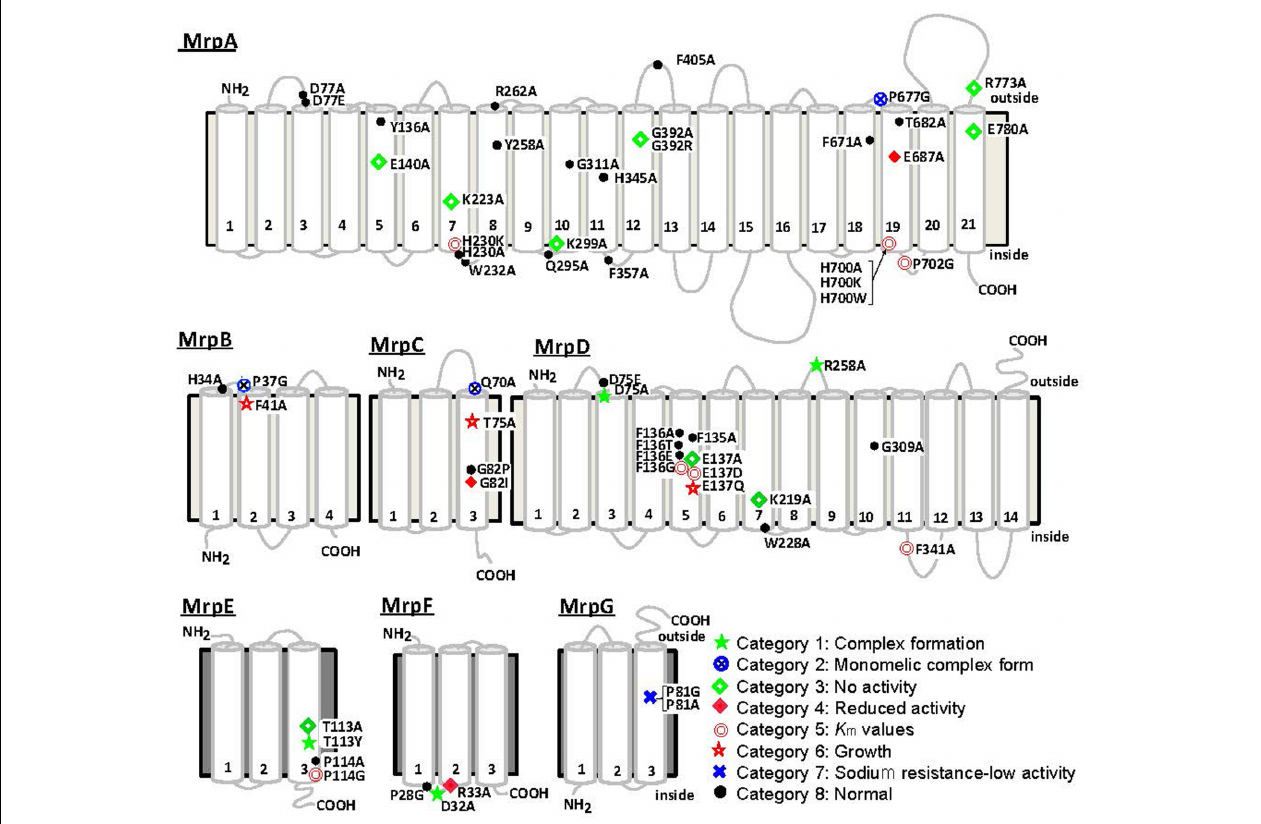
FIGURE 5 | Transmembrane topology of Bp–Mrp proteins and positions of mutations. Transmembrane segments predicted by ConPred II, HMMTOP, and TMHMM (available online) were used in the analyses of the secondary structure predictions for each Mrp subunit.